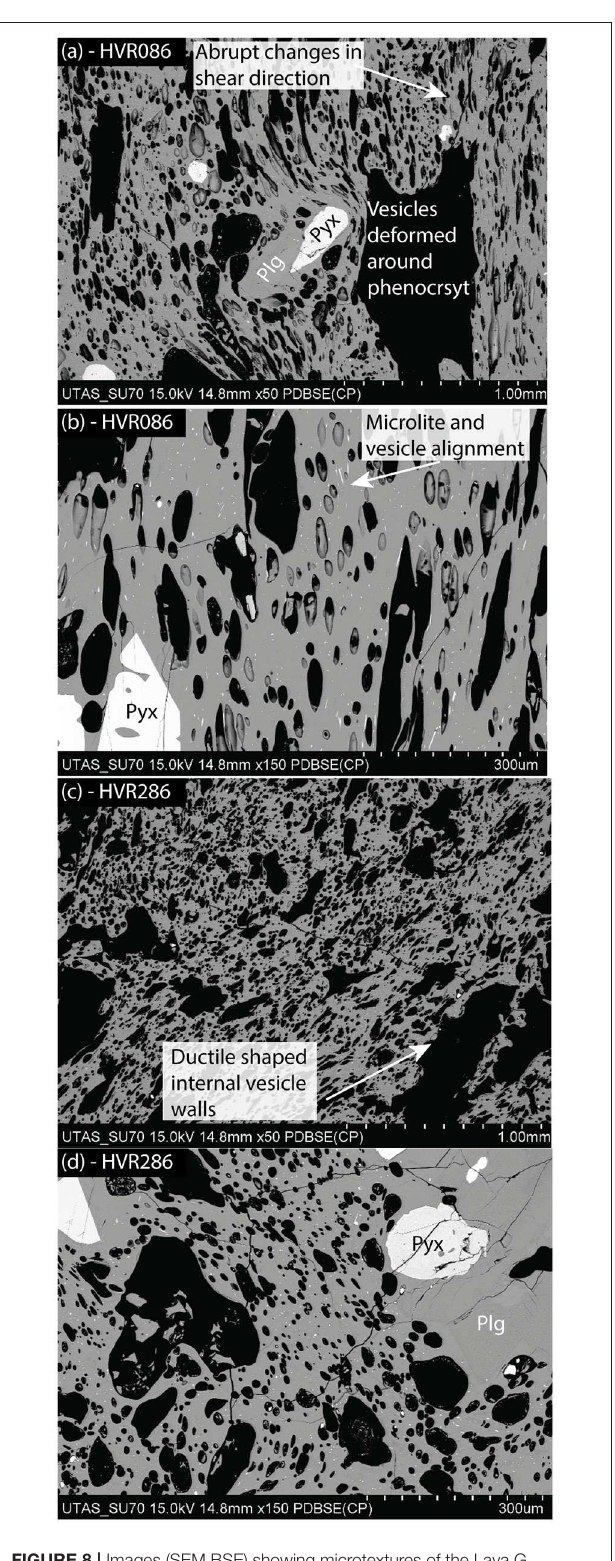
FIGURE 8 | Images (SEM BSE) showing microtextures of the Lava G pumiceous carapace from samples HVR086 (a,b) and HVR286 (c,d) at